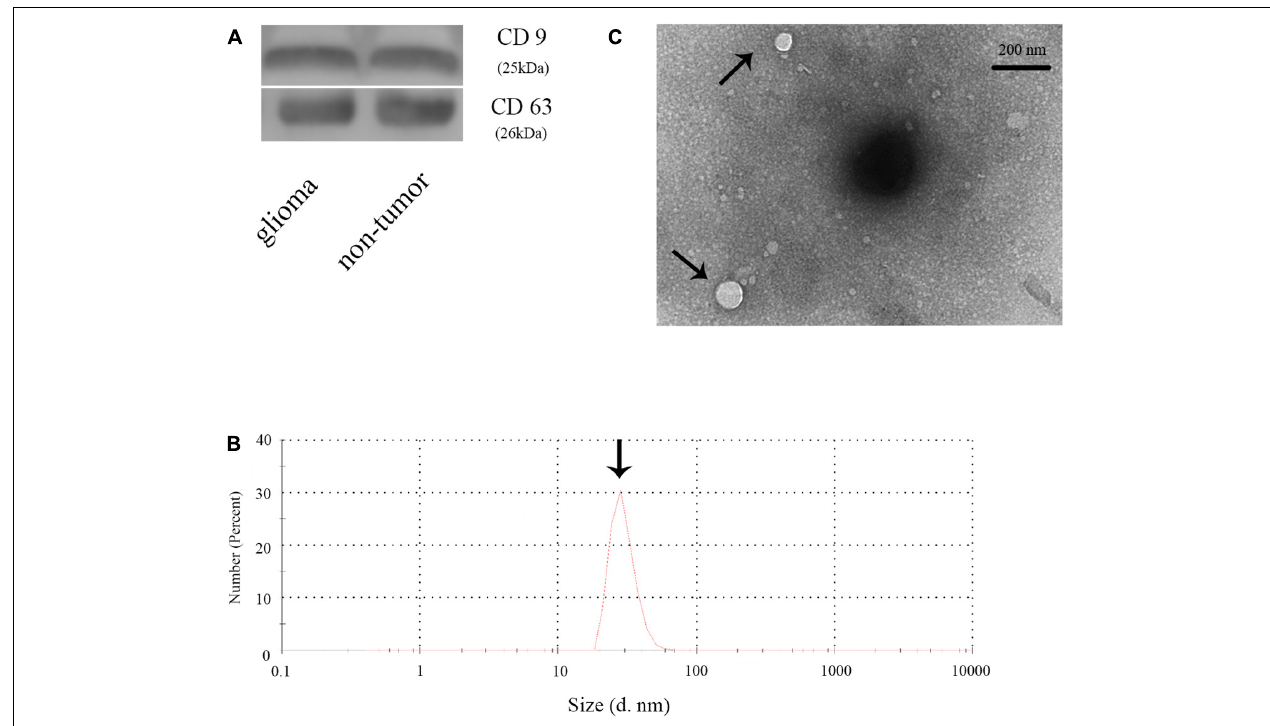
FIGURE 1 | Identification of plasma exosomes. (A) The expression of CD9 and CD63 in plasma exosomes in glioma and non-glioma patients. (B) Determination of the exosome diameter by Nano-Sight. (C) Transmission electron microscope image of the plasma exosomes.